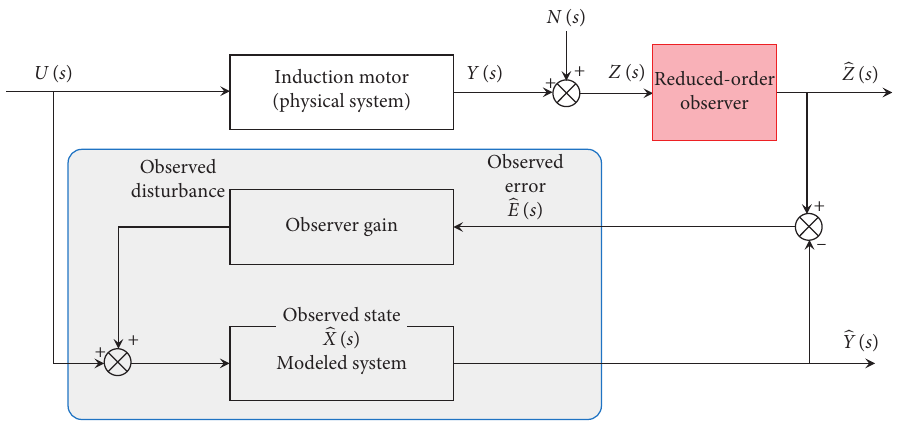
Figure 5: Proposed structure using the reduced-order